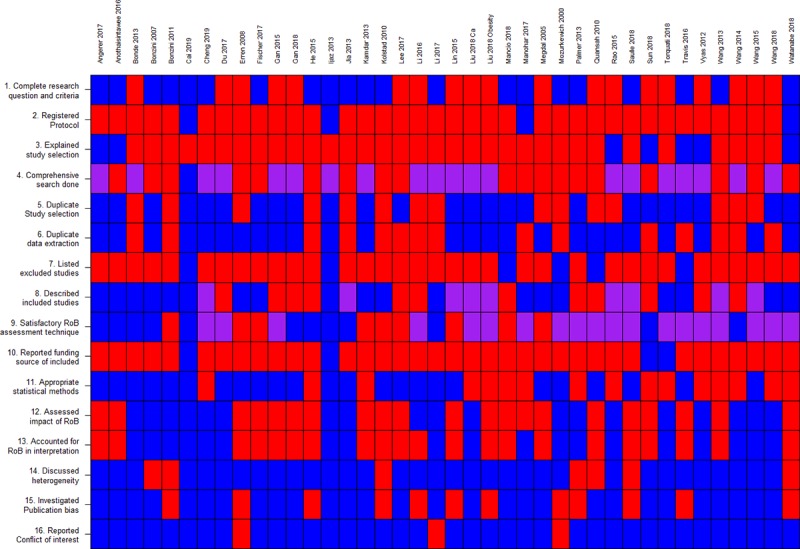
Quality assessment of included reviews using AMSTAR v2 (n = 41).Red is not fulfilled, blue is fulfilled, and purple is partially fulfilled. RoB means risk of bias.